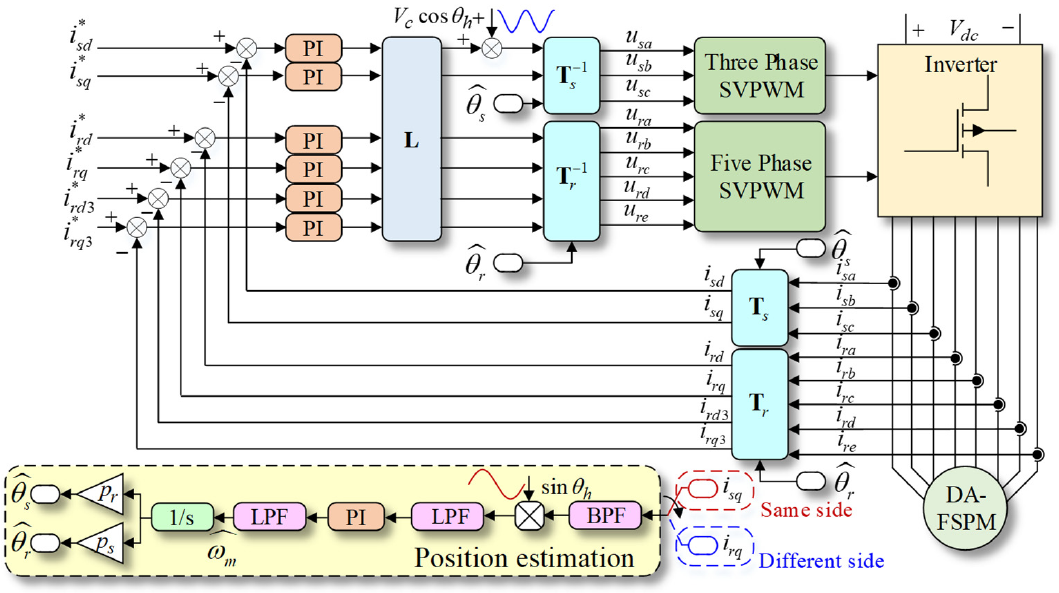
Figure 8. The sensorless vector control for DA-FSPM based on high-frequency voltage injection.